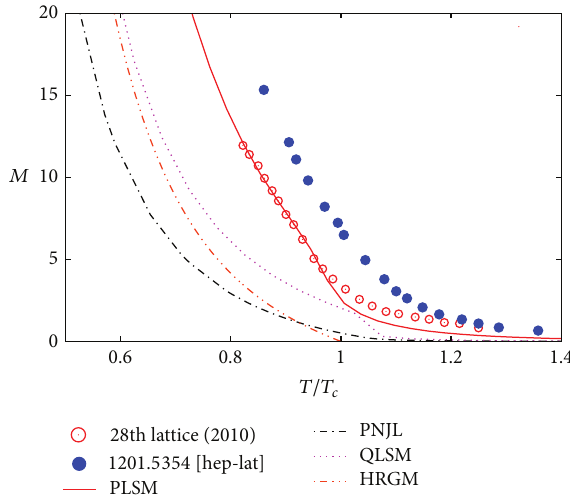
Figure 1: The thermal behaviour of the dimensionless chiral order parameter, 𝑀 , calculated as function of temperature from the four SU (3) effective models, PLSM (solid curve), QLSM (dotted curve), PNJL (double-dotted curve), and HRG (dash-double-dotted curve), and compared with the lattice QCD calculations (solid circles) [47] and (open circles) [48] at 𝑚 𝑙 /𝑚 𝑠 = 0.037 .